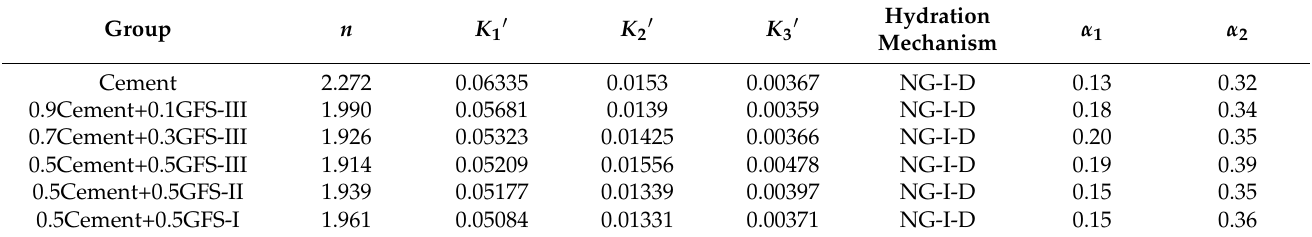
Table 4. Kinetic parameters of gasification slag composite cementitious material.